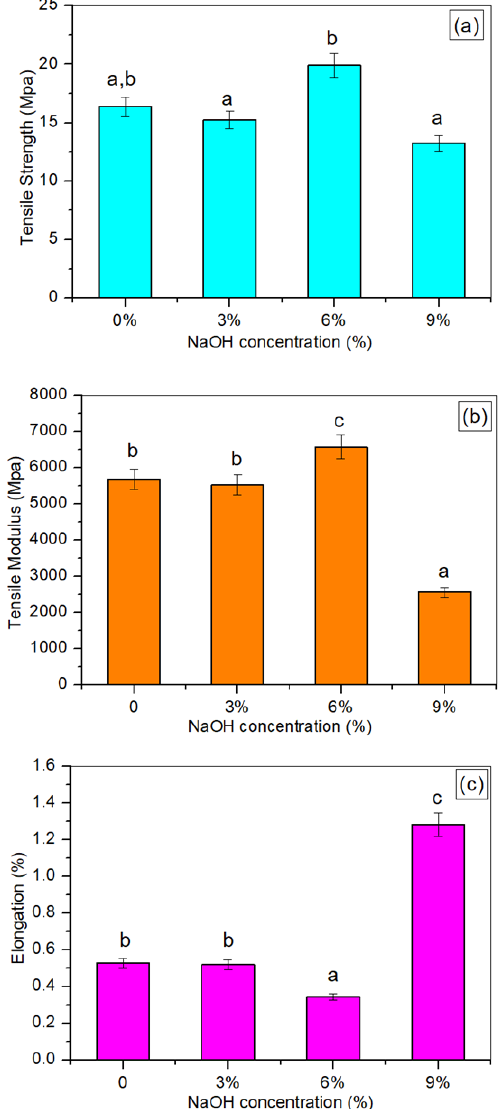
Figure 3. The ( a ) tensile strength, ( b ) tensile modulus, and ( c ) elongation at break of untreated and treated TPCS/PW/CCF composites at different NaOH concentrations. Letters a, b, and c is indicates the group of data for statistical analysis.